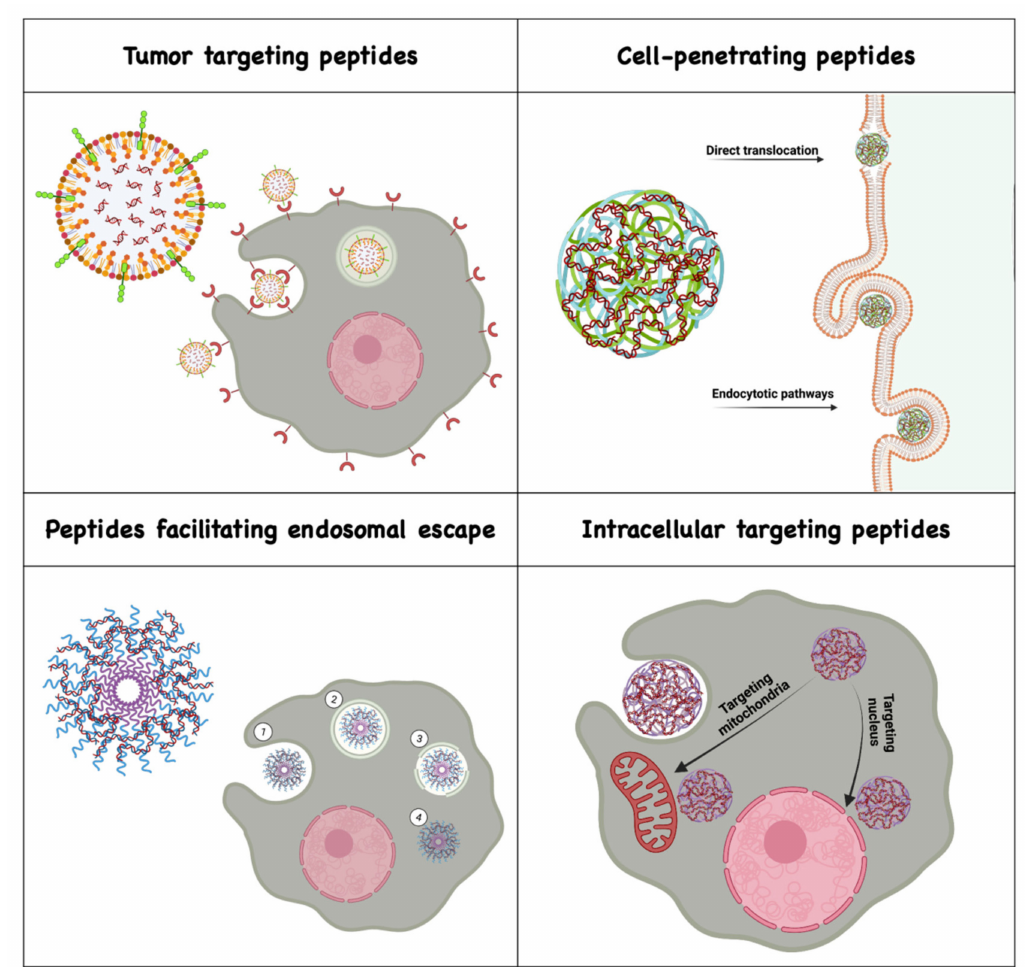
Figure 1. Classes of membrane active peptides facilitating the delivery of nucleic acid across biological barriers. Created with BioRender.com (Access to BioRender: